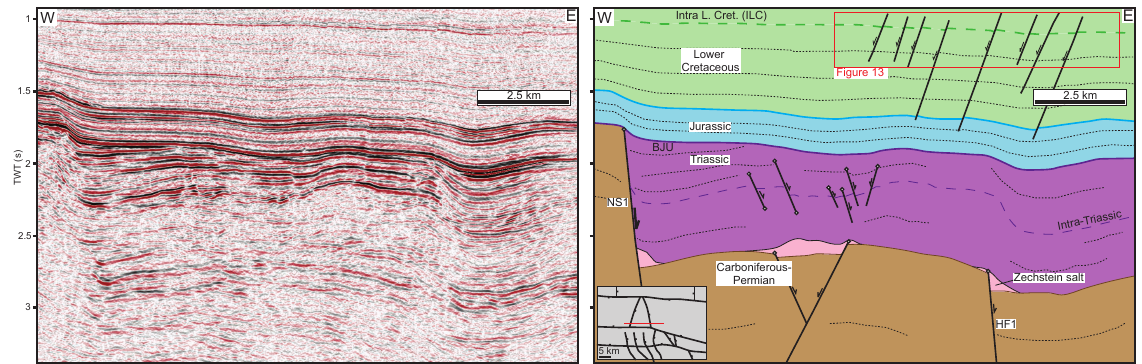
Figure 9. Interpreted and uninterpreted E–W-oriented 2-D seismic section located across NS1 and within the hangingwall of the Fjerritslev north fault. Triassic activity occurs across NS1, with little Early Cretaceous activity observed. Note the geometric similarities between NS1 and HF1 in this section, and NS2 and HF2 in Fig. 5. See Fig. 1c for